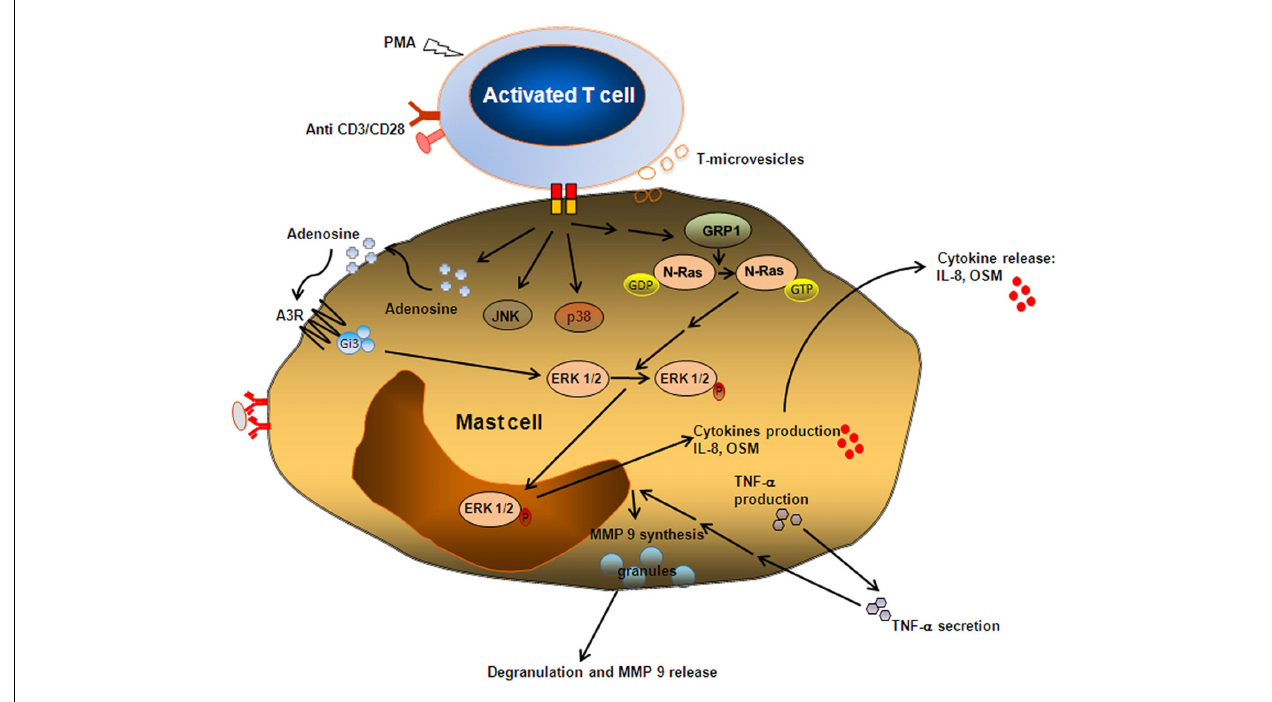
FIGURE 1 | Heterotypic adhesion-induced mast cell activation. Mast cells can be activated by physical contact with activated, but not resting,T cells and/or by microvesicles released from the latter.This contact involves adhesion molecules such as integrins, lymphotoxin β receptor, and other yet unspecified surface molecules. Contact with membranes, derived from activatedT cells, stimulate ERK1/2 activation, causing the expression of cytokines, chemokines, and growth factors. On contact withT cell membranes, adenosine is formed and released. By binding to its specific